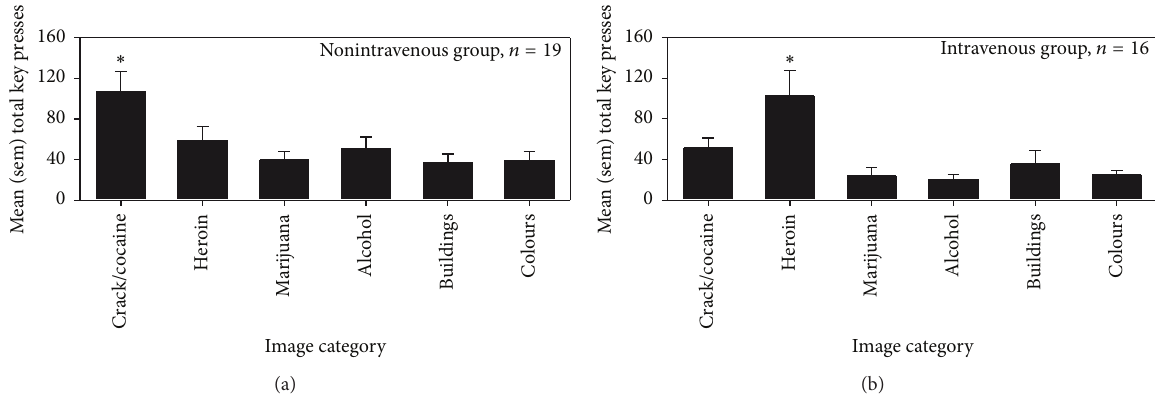
Figure 3: CRT performance of volunteers tested at Stonehenge Therapeutic Community. Mean and sem total number of responses made on computer keys by groups created on the basis of route of administration ((a) = nonintravenous (smoking/snorting), 𝑛 = 19 ; (b) = intravenous, 𝑛 = 16 ). The ∗ indicates a significant difference, within group, between responding a specific key and all other